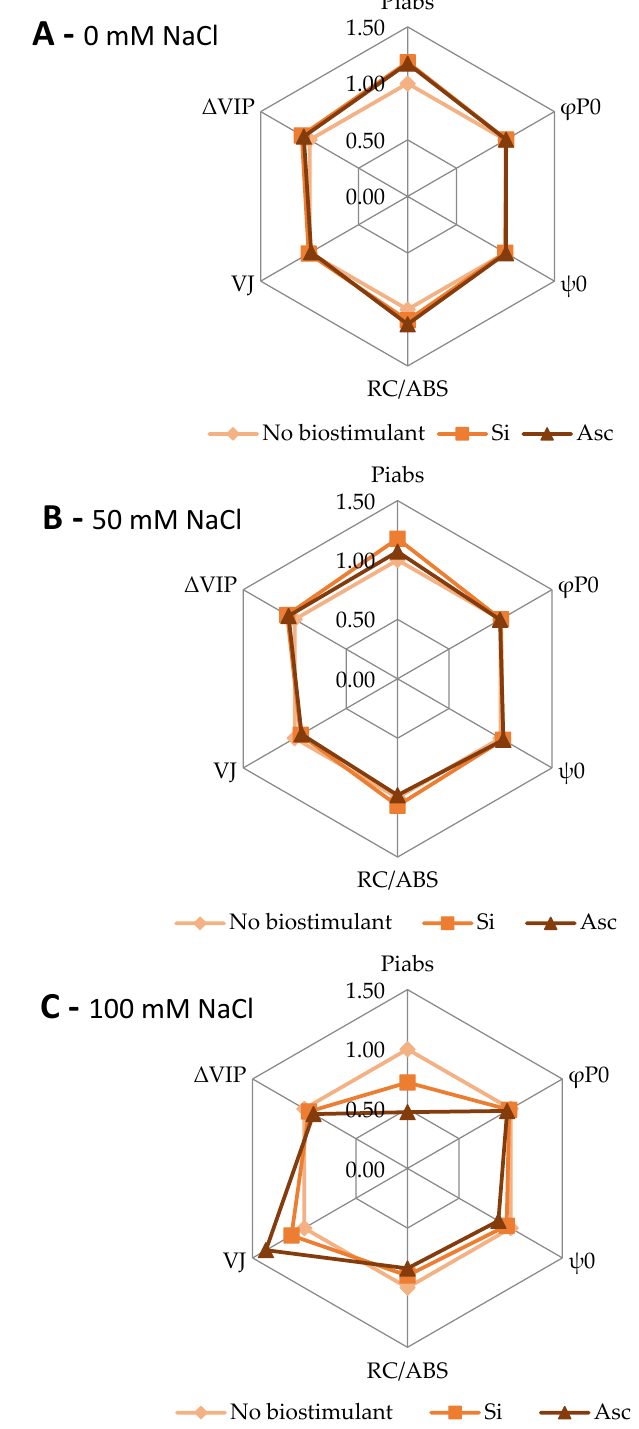
Figure 3. OJIP parameters normalized to the values of the non-biostimulant treatments. ( A ) 0 mM NaCl, ( B ) 50 mM NaCl, and ( C ) 100 mM NaCl. Post hoc statistical analysis is displayed in Table 2.